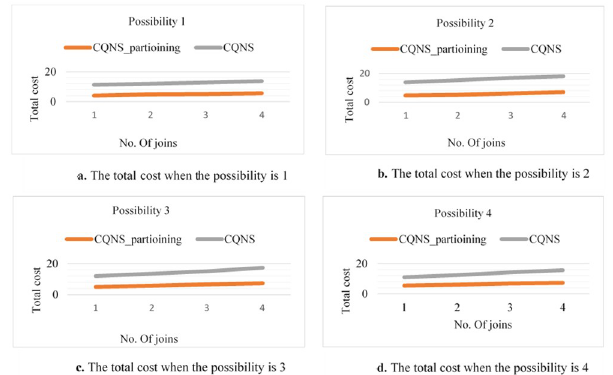
Fig 18. Comparison of the total cost using CQNS in Cassandra with edge partitioning and CQNS without partitioning on linear joins.